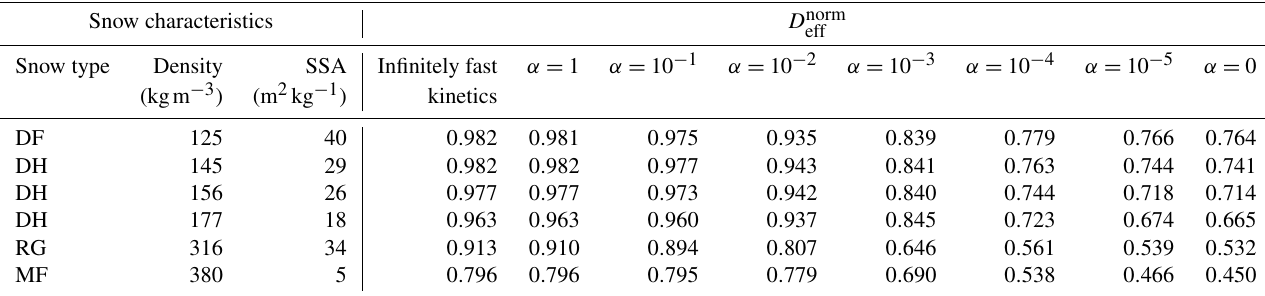
Table 1. Computed normalized effective diffusion coefficients as a function of surface kinetics (columns) and snow sample (lines). Values are derived from simulations with a 50Km − 1 thermal gradient, but our results suggest that they are independent of the thermal gradient. Snow types are classified according to Fierz et al. (2009), and SSA stands for specific surface area.